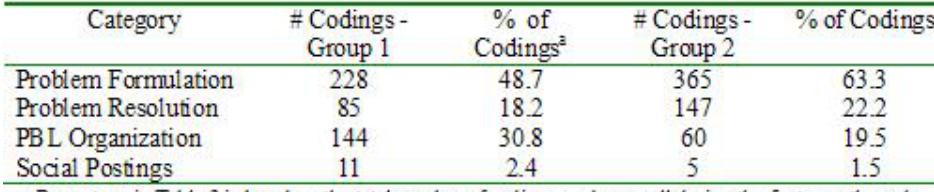
Table 2. Coding of PFR Categories in AgroEcology Case 2 – First